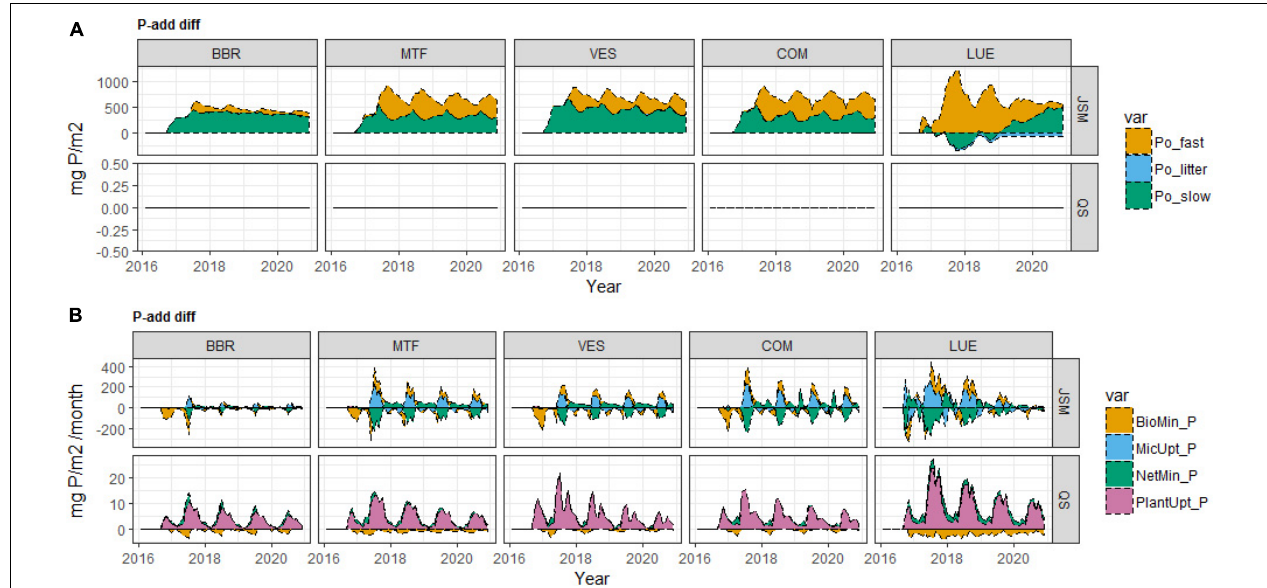
FIGURE 6 | Simulated (A) soil organic P (SOP) pool responses and (B) organic P cycling processes responses to P addition (P-add diff) of JSM and QUINCY-soil (QS) at the study sites along the soil P gradient (BBR > MTF > VES > COM > LUE). Fast P refers to P in microbe, microbial residue and dissolved organic matter (DOM) pools in JSM, and P in fast SOM pool in QUINCY-soil; slow P refers to P in mineral-associated DOM and mineral-associated residue pools in JSM, and P in slow SOM pool in QUINCY-soil; litter P refers to P in litter in both models. Organic P cycling processes include bio-mineralization, microbial uptake, net mineralization, and plant uptake of P. Time for P addition: September